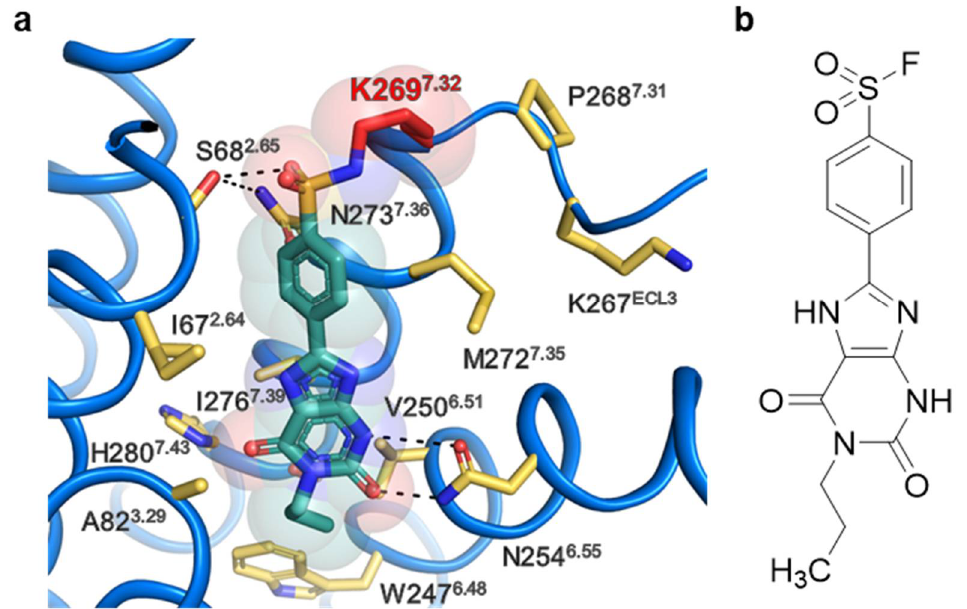
Figure 5. Suggested irreversible binding mode of PSB-21500 ( 6a ) to the A 2B AR. ( a ) Docking pose of 6a in the previously published A 2B AR homology model [18]. The lysine residue in position 269 7.32 was chosen as an anchor for nucleophilic substitution. Covalent docking was performed using Maestro (Schroedinger). ( b ) Chemical structure of PSB-21500.